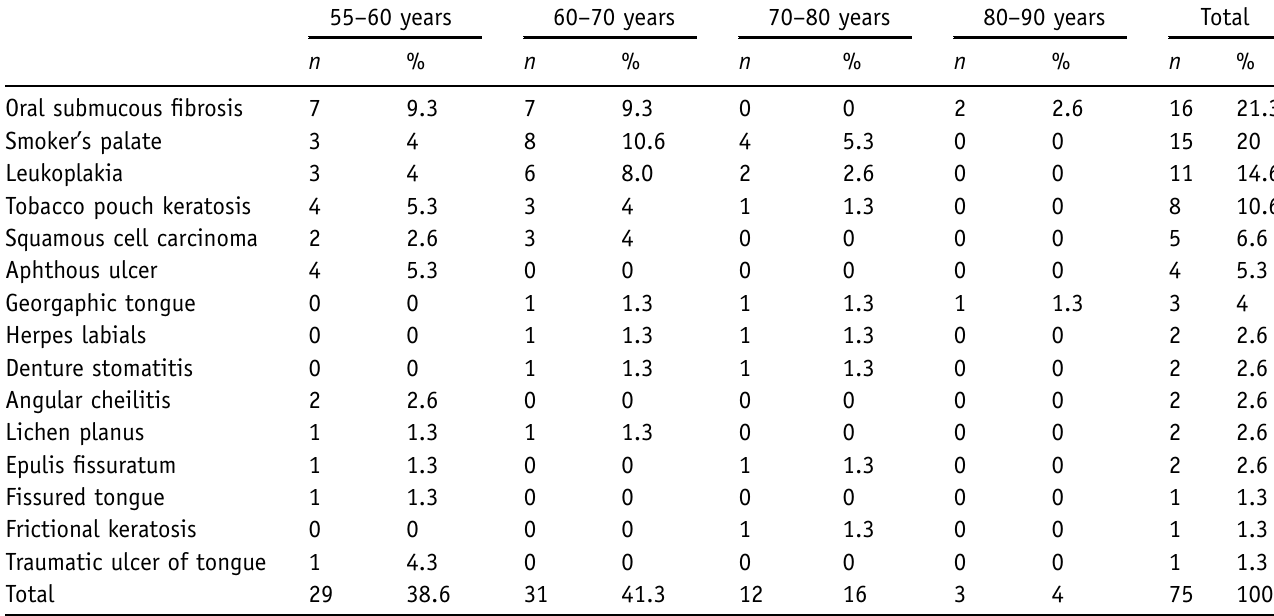
Table I. Prevalence of oral mucosal lesions in four age